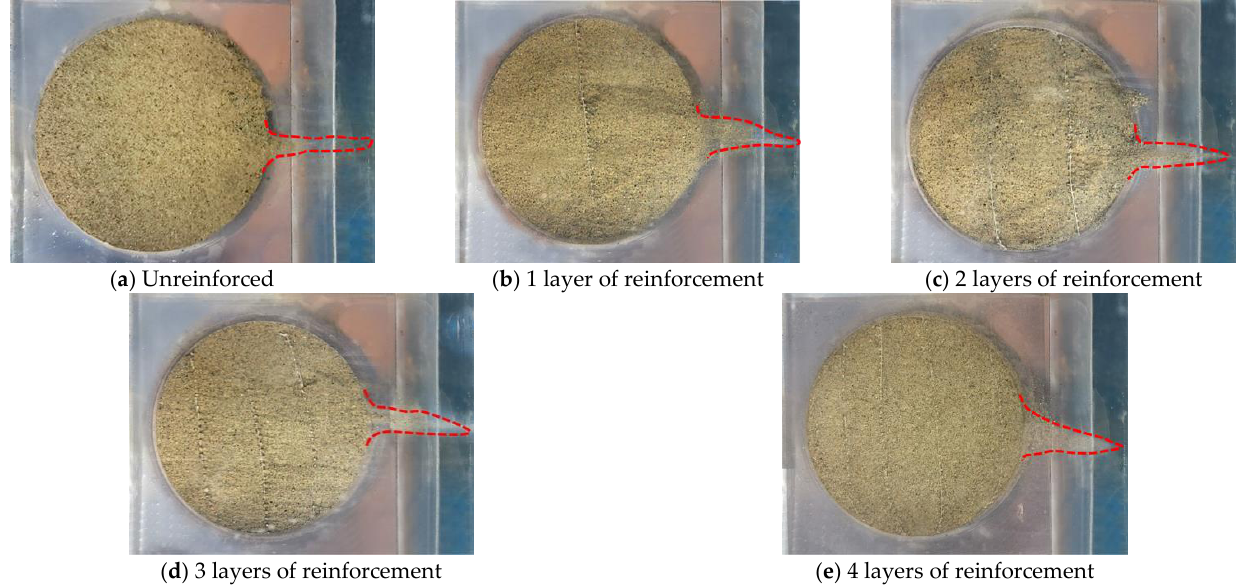
Figure 8. Incipient motion diagram of tailings particles with different reinforcement layers.